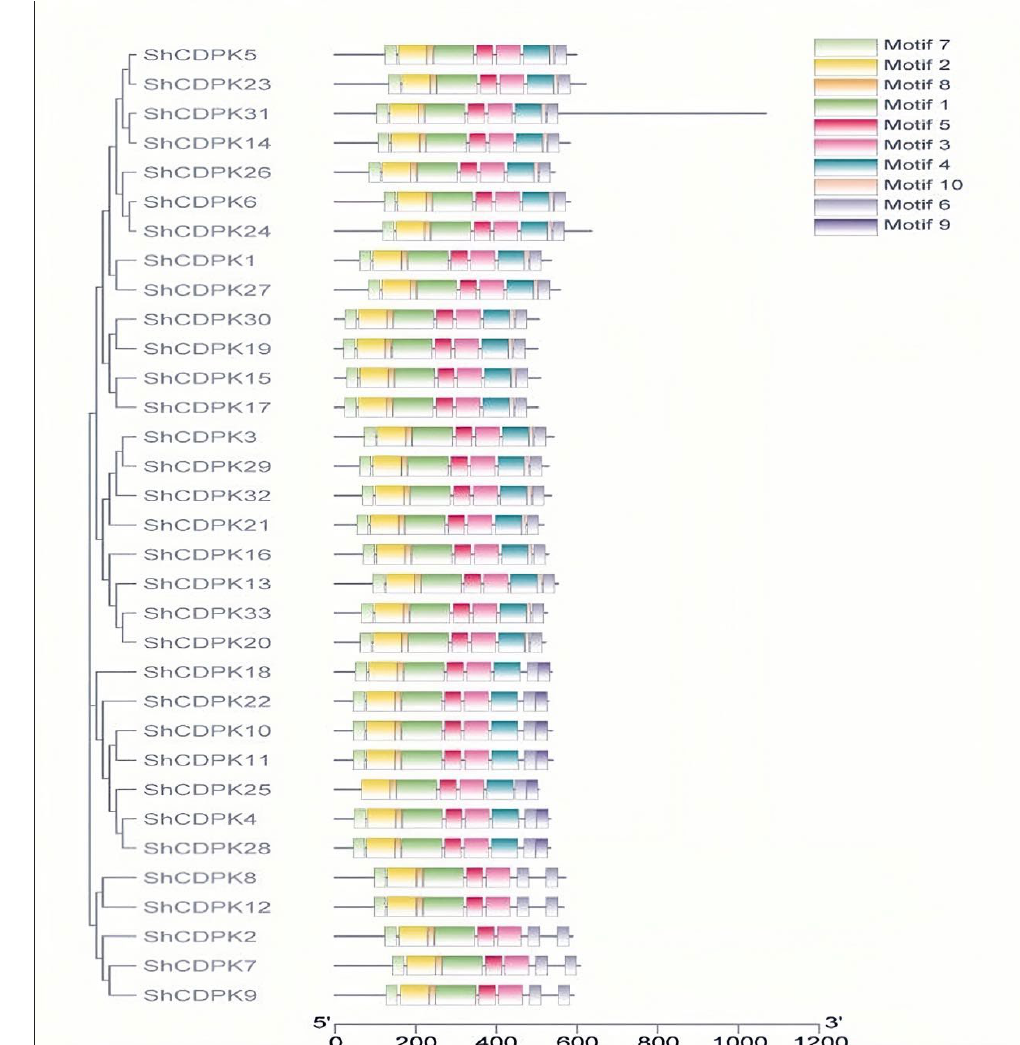
Figure 3. Conserved motif types of CDPK gene family in Solanum habrochaites .